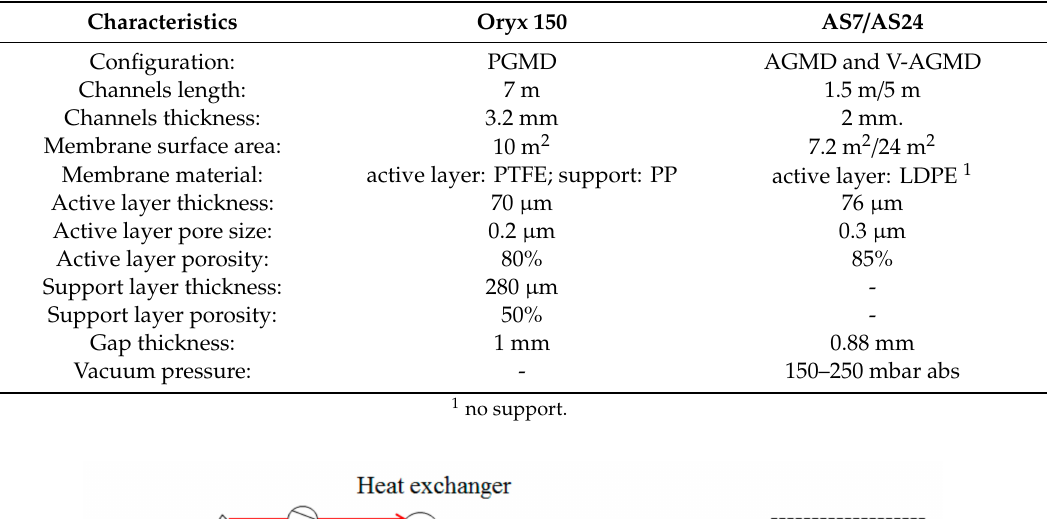
Table 1. Characteristics of the membrane distillation (MD) commercial modules used in this study.